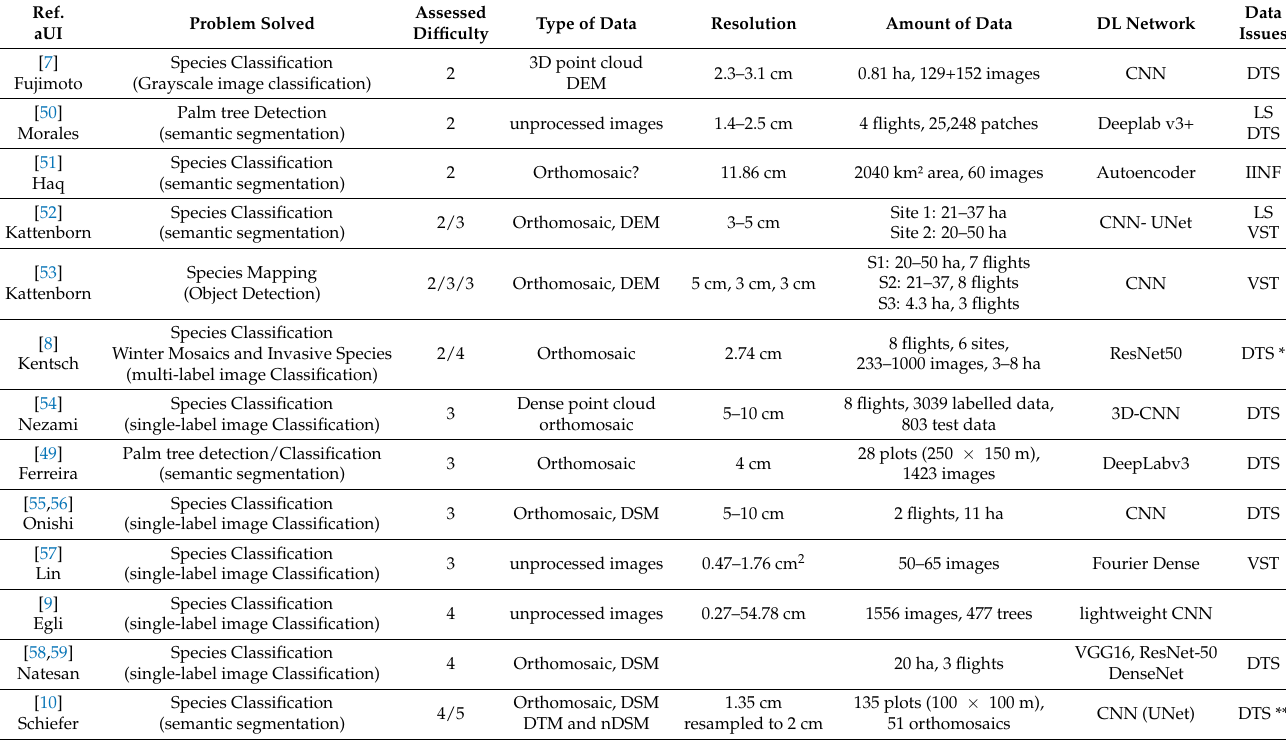
Table 3. Summary of Tree Species Classification papers reviewed. Regarding the “Data Issues” column, the following notation is used: “Wrong Split” (WS), “Late Split” (LS), “validation set for testing” (VST), “dependent test set”(DTS) or “insufficient information” (IINF); see Section 3 for